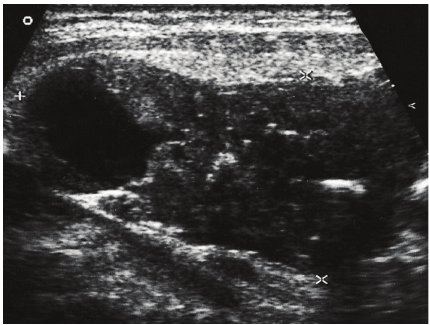
Figure 5: Ultrasound finding of parathyroid carcinoma (longitudi- nal)—a tumor with cystic degeneration and